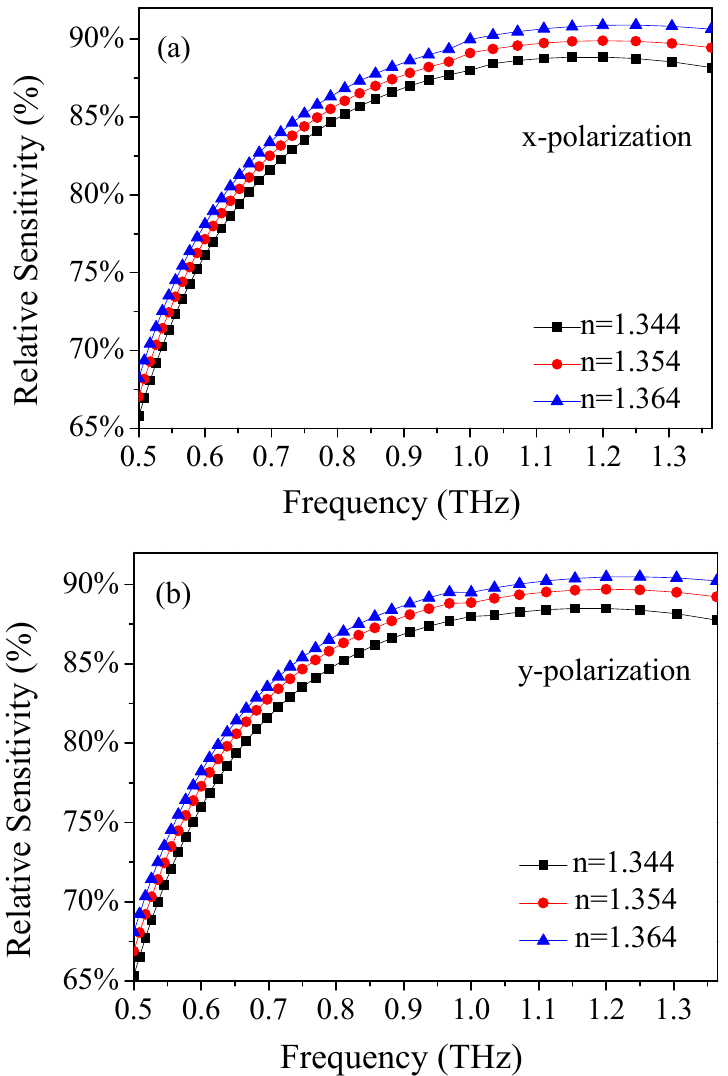
Figure 6. Frequency dependence of the relative sensitivity of ( a ) x- and ( b ) y-polarization for refractive index of analyte.